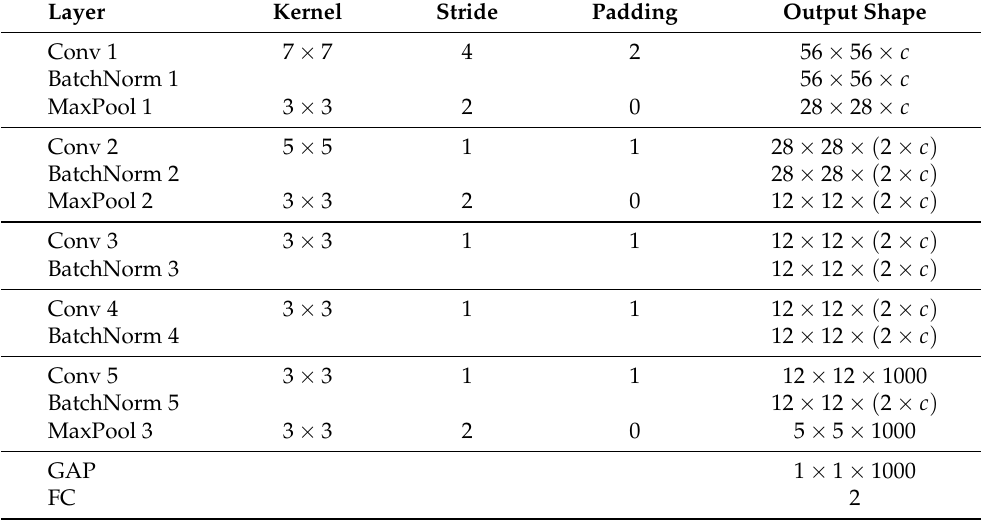
Table 3. Configuration of one CNN consisting of MM-CNN when c is introduced in the output channel of the convolution